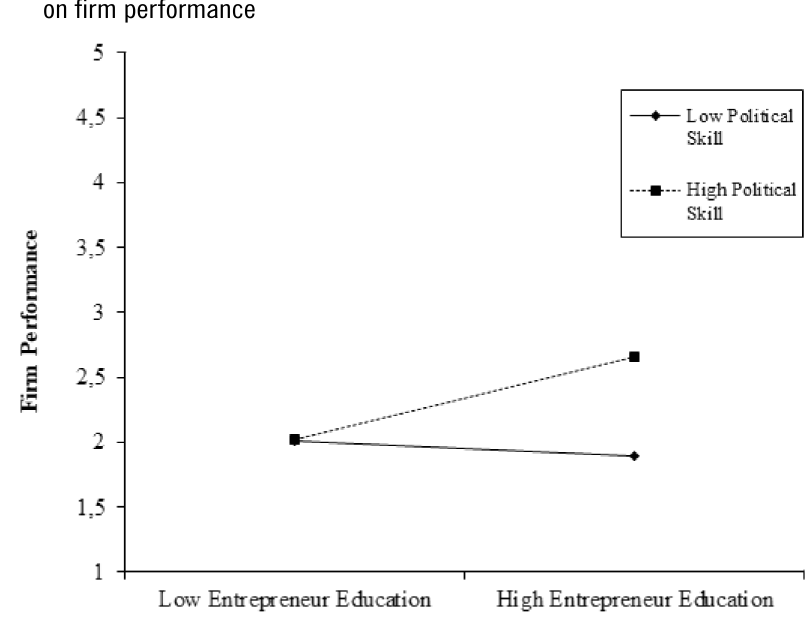
Figure 2. Interaction of women entrepreneurs’ education and political skill on firm